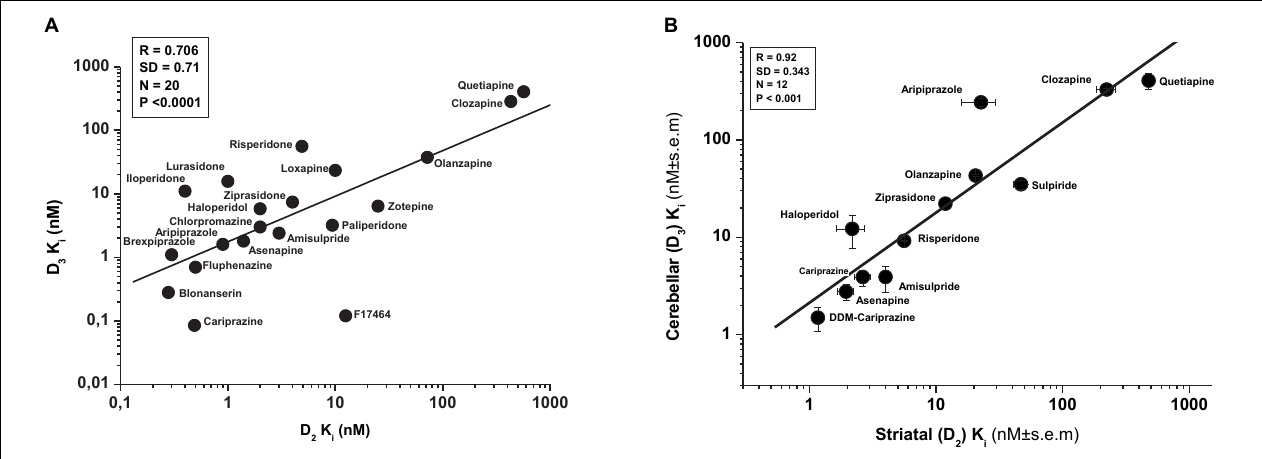
FIGURE 3 | Correlation between in vitro affinity of antipsychotics for human D 2 Rs and D 3 Rs ( A , data taken from Table 1 ; various radioligands) and for rat striatal D 2 Rs (striatal membrane) and cerebellar D 3 Rs (CB L9,10 membrane) (B) ; rat D 2 R and D 3 R affinity data derive from the extension of the study of Kiss et al. (81) and Kiss et al. (82). Determination of D 2 R and D 3 R affinity in membranes from CHO cells expressing human D 3 R or cerebellar L9,10 membranes (ligand: [ 3 H]-(+)-PHNO) is described in Kiss et al.